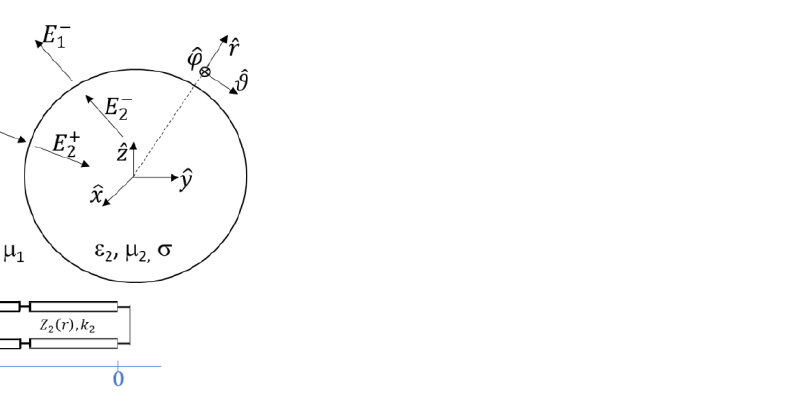
Figure 3. Equivalent transmission line for the case of an inward spherical wave incident on a spherical boundary.